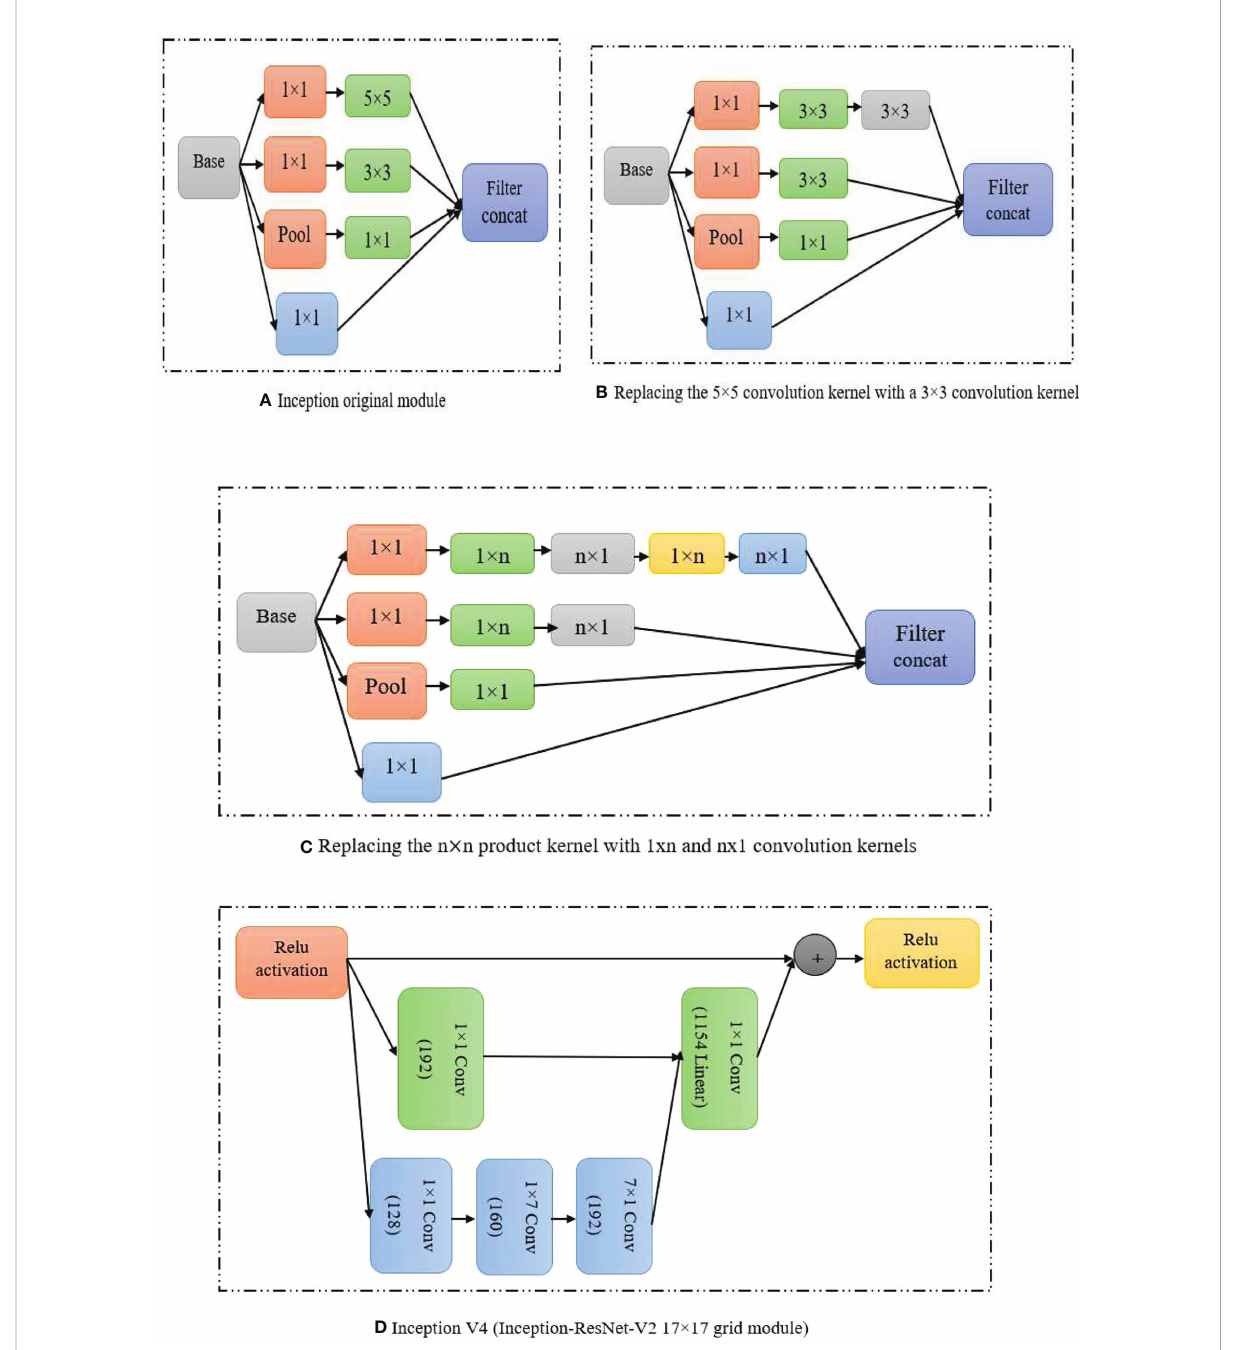
stems was 88%. Mahanti et al. (2021) used line scanning